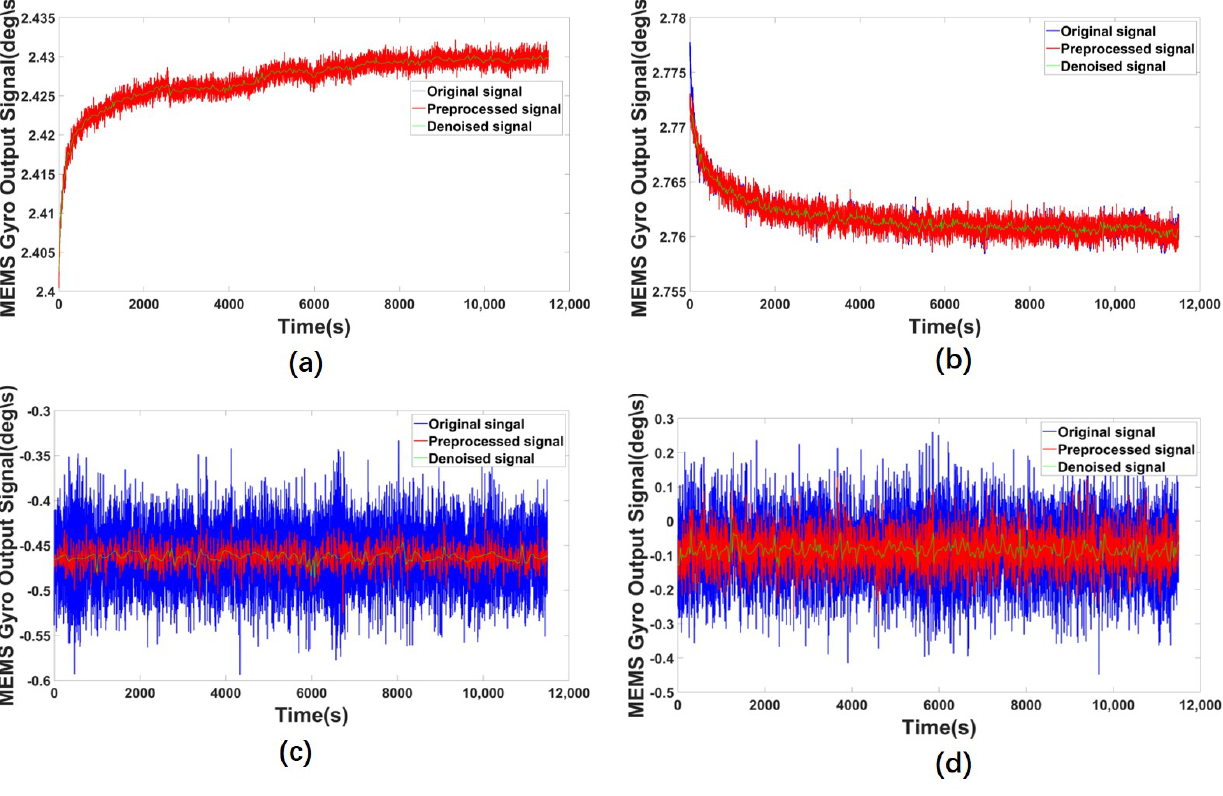
Figure 10. Denoising results of ICELMD, ( a , b ) are collected by different gyros, and ( c , d ) are collected by